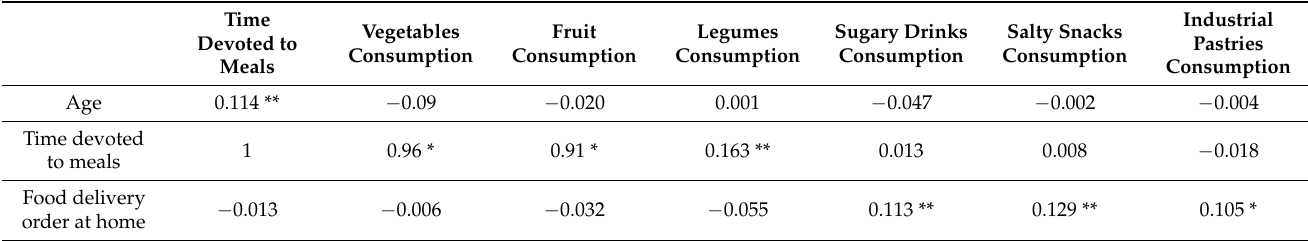
Table 6. Correlations between main